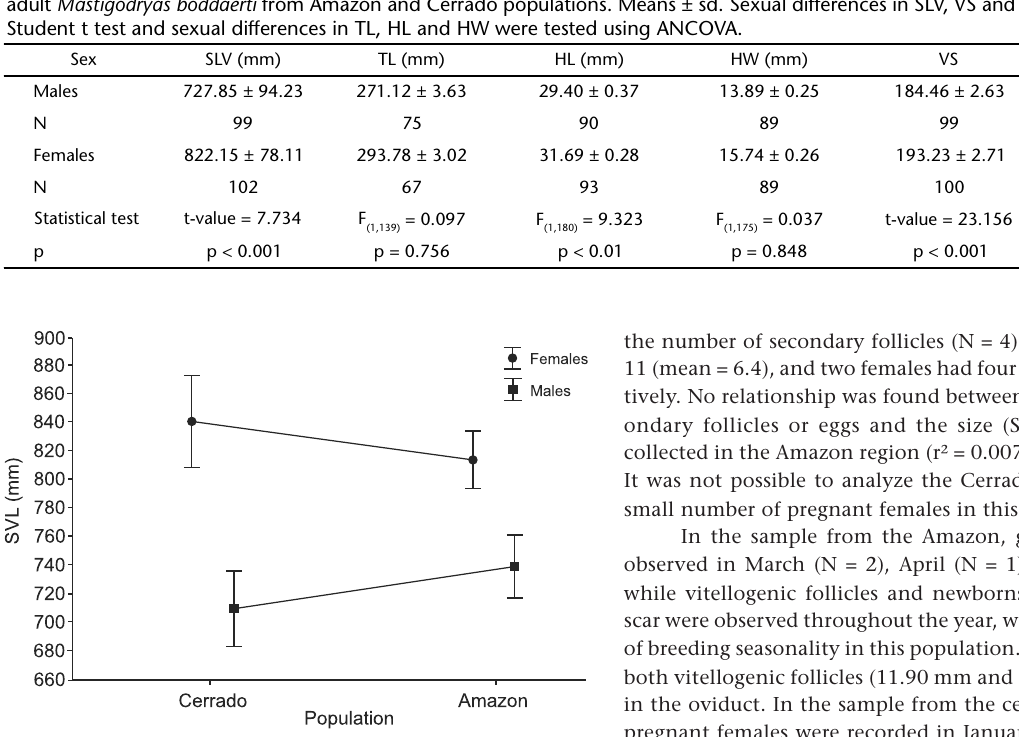
Figure 1. Variation in the degree of sexual size dimorphism (SVL) between the Amazonian and Cerrado populations of Mastigodryas